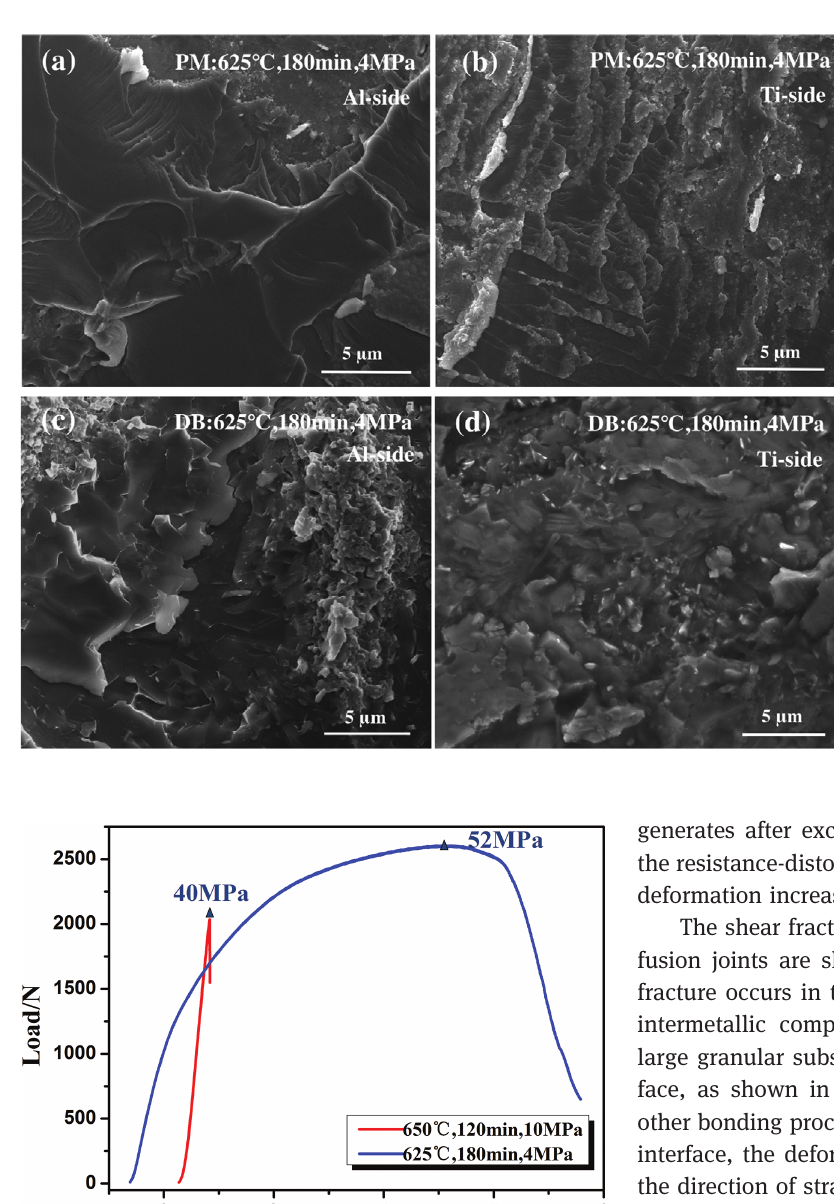
Figure 10: The load – displacement curve of shear strength of Ti/Al diffusion bonded